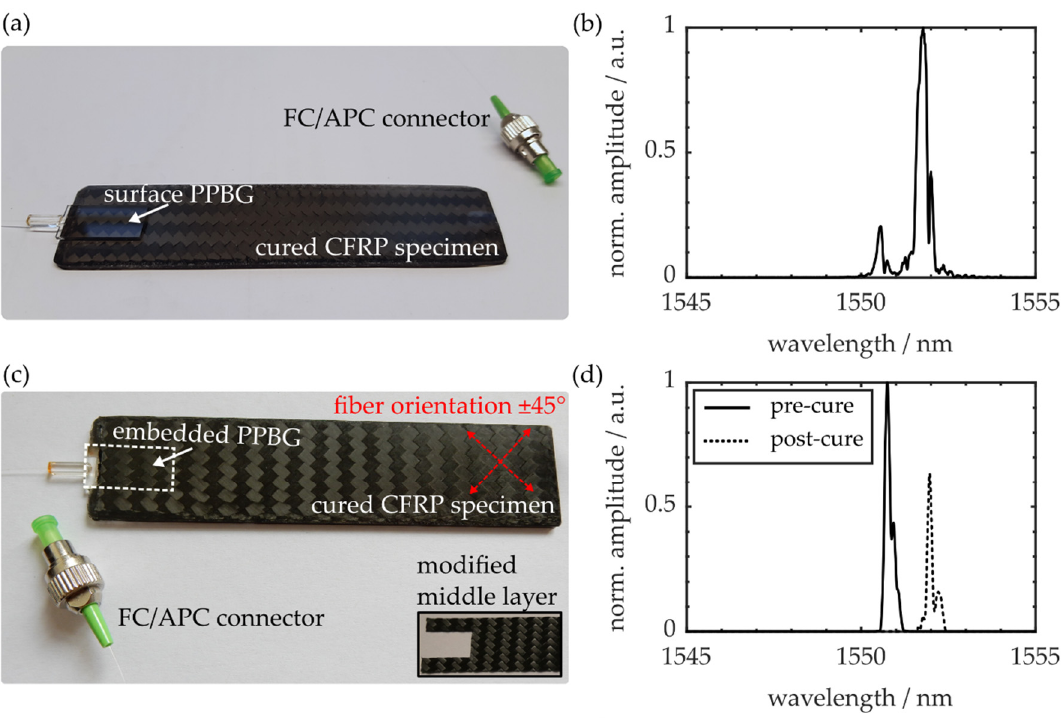
Figure 2. ( a ) Cured CFRP specimen with affixed COC-PPBG and ( b ) sensor signal; ( c ) Cured CFRP specimen with an integrated COC-PPBG; ( d ) Respective sensor signal before and after curing.